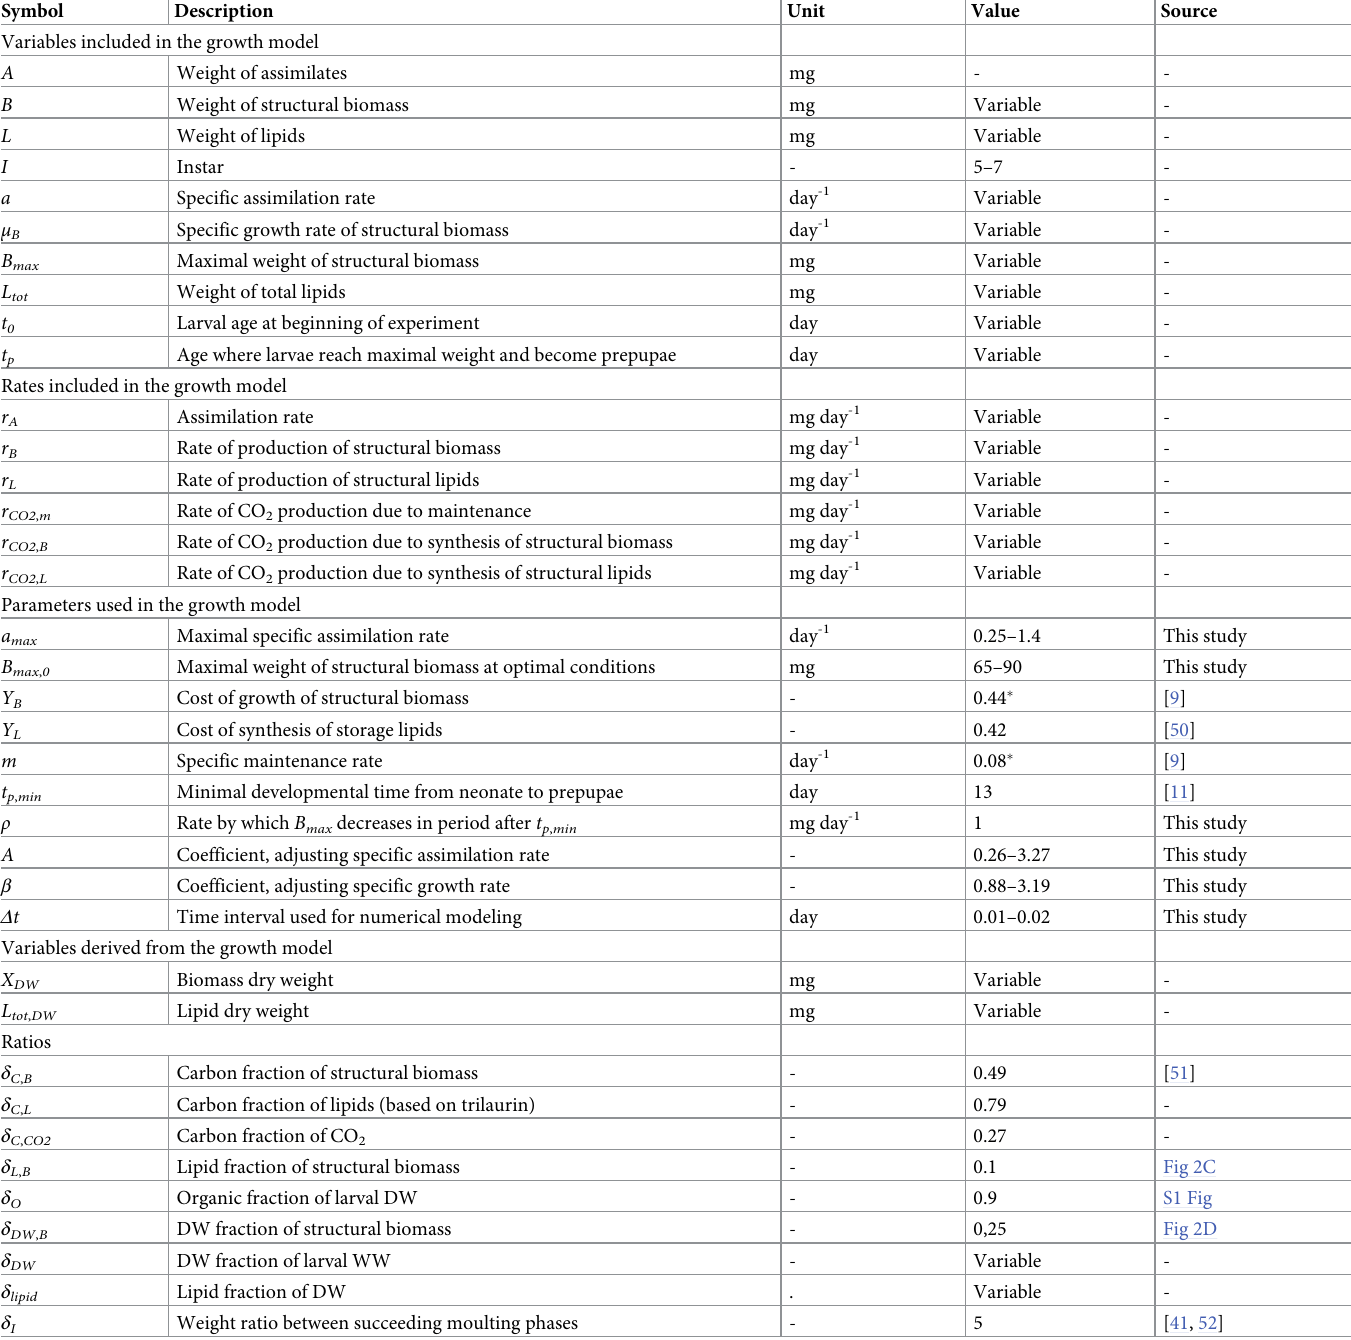
Table 1. Variables and parameters used for modelling of growth and biomass composition in BSF larvae by Eqs 1–22.